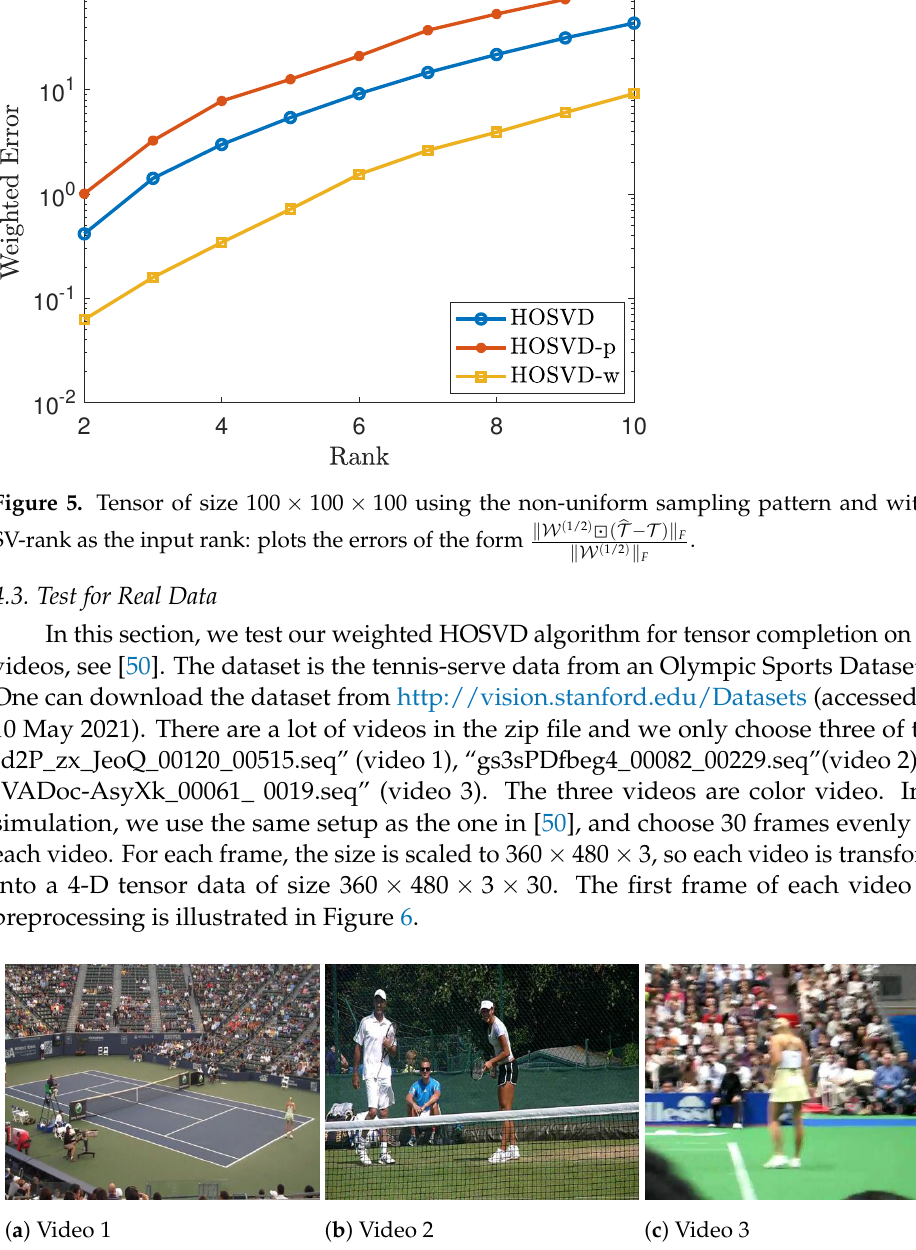
Figure 6. The first frame of videos